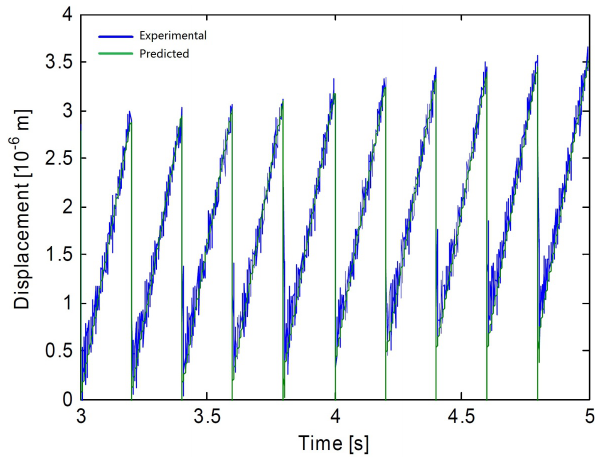
Figure 21. Displacement predicted using LuGre model. model using the system identification technique. The details are as follows.